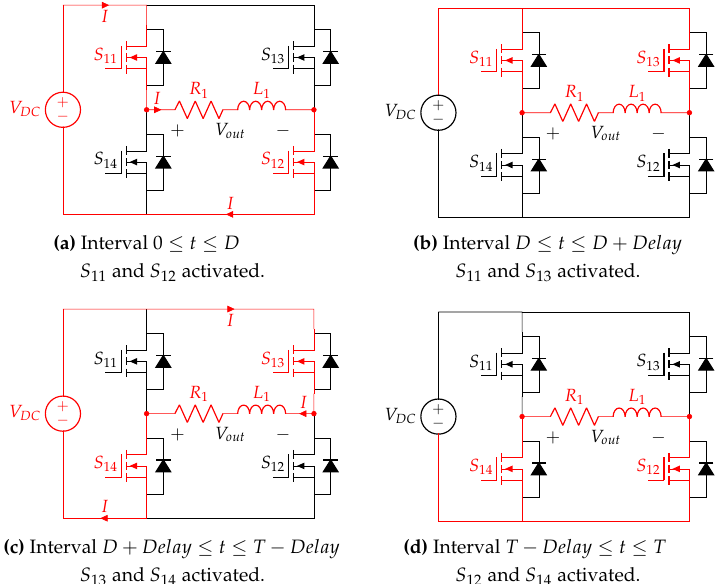
Figure 6. Operation of phase-shifting technique in a full-bridge inverter.